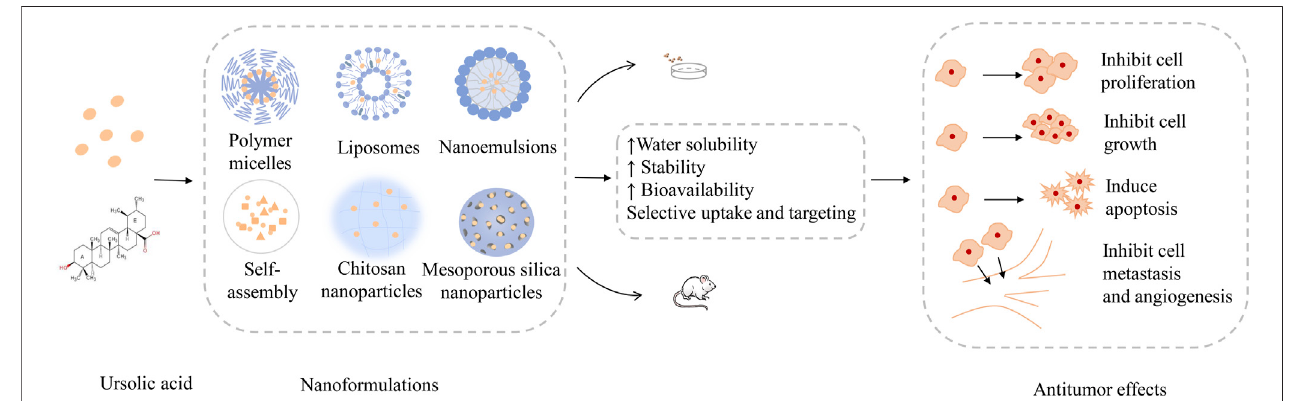
FIGURE 5 | The main properties of UA nanoformulations and their therapeutic ef fi cacy. UA nanoformulations are designed in a variety of ways, such as, polymer micelles, liposomes, nanoemulsions, nanoparticles, etc. Con fi rmed by a large number of cell and animal experiments, the UA nanoformulations can improve the water solubility, stability, bioavailability and tissue targeting of UA molecules, and achieve good anti-tumor effect by inhibiting the growth, proliferation and metastasis of tumor cells, promoting tumor cell apoptosis and inhibiting tumor angiogenesis. Abbreviations: UA, ursolic